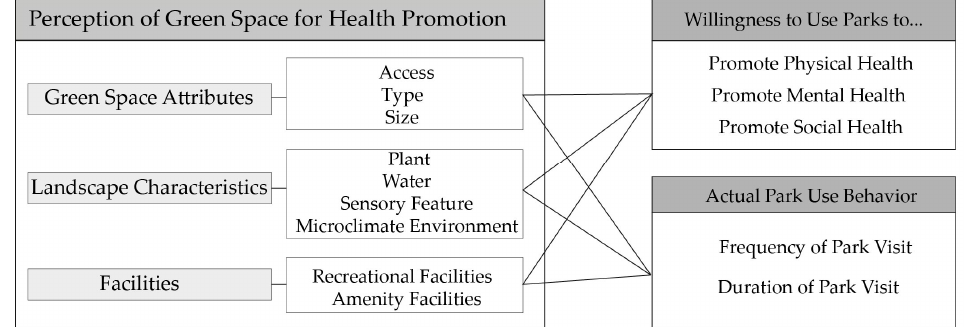
Figure 1. Potential relationships among perception of green space for health promotion, willingness to use parks and actual park use behavior among young urban residents.